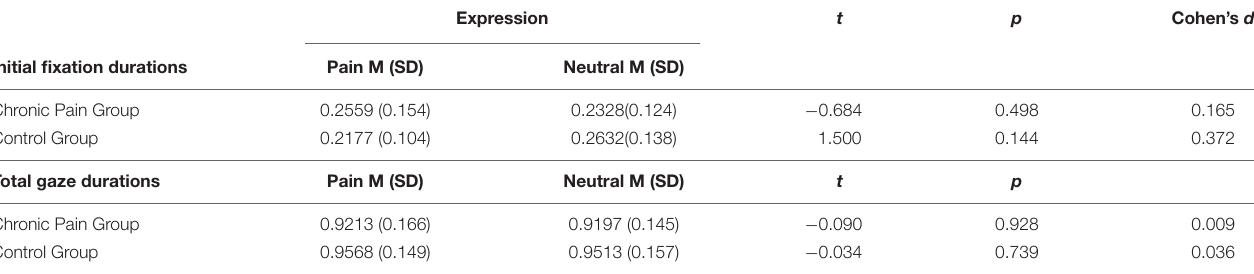
TABLE 2 | Means/SD/ t -test results of the initial fixation and total gaze durations by groups.